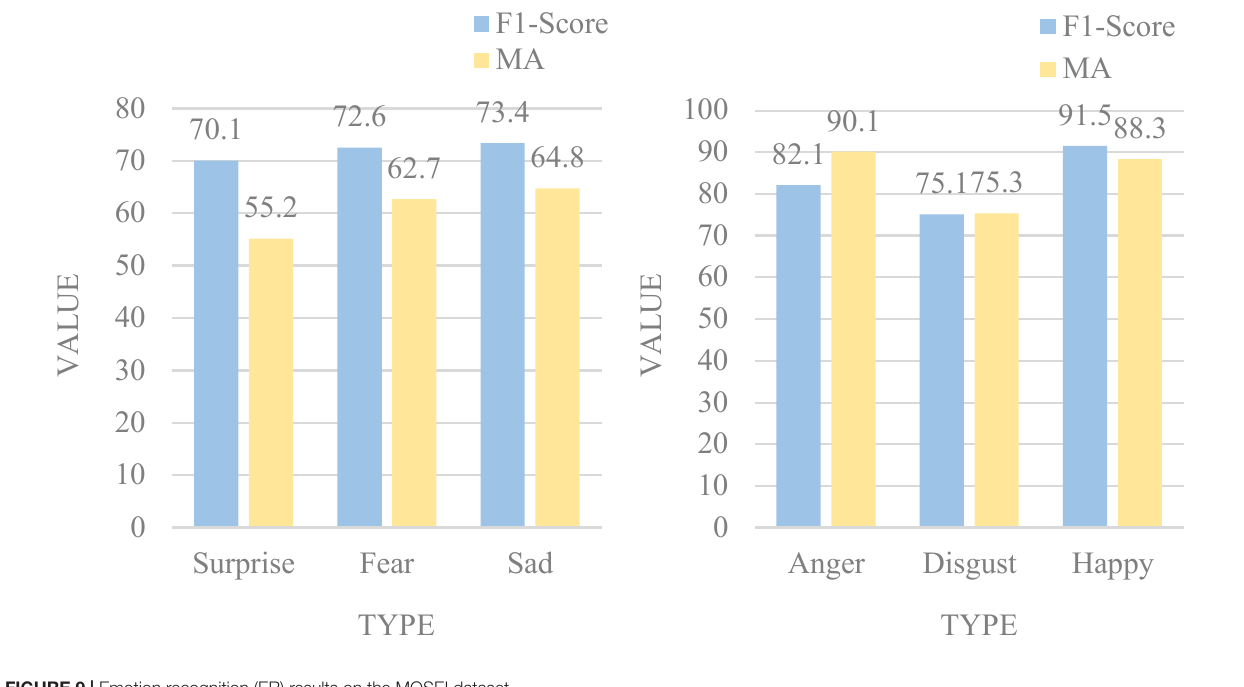
parts of the videos. The experimental results are verified by comparing the experimental data of single-modal ER and multi-modal ER. On the basis of experiments, the analysis shows that the recognition of single modality is lower than the effect of multimodal ER, which proves that introducing additional methods will significantly improve the accuracy of